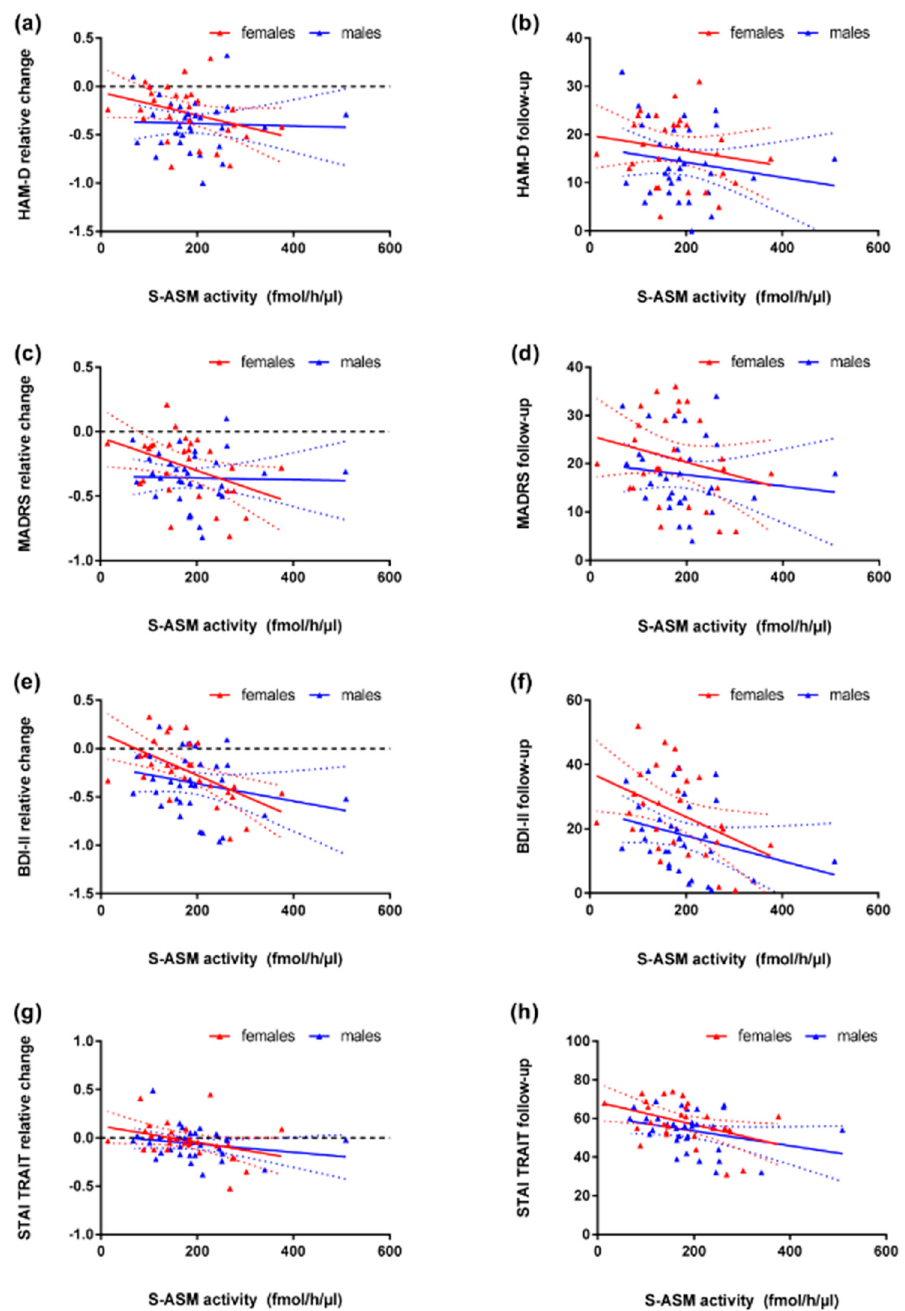
Figure 3. Correlation of serum acid sphingomyelinase (S-ASM) activity at inclusion with change in depression severity from inclusion to follow-up (approximately 3 weeks) and score at follow-up assessed by MADRS ( a , b ), HAM-D ( c , d , both administered by a clinician), and BDI-II ( e , f , self-report) inventories for female (red) and male (blue) medicated patients with current major depressive episode. High S-ASM activity is related to the stronger improvement of depression in the whole group and particularly the female subgroup. ( g , h ) Correlation of S-ASM activity at inclusion with the change of STAI trait score during treatment and with the score at follow-up in medicated patients. Individual data with linear regression line and 95% confidence intervals.